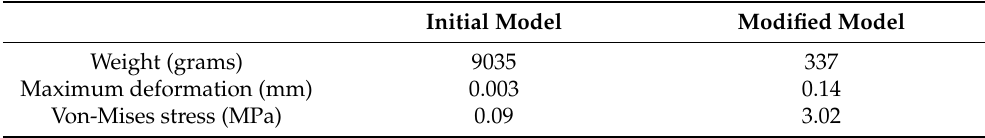
Table 4. Equivalent stress and maximum deformation for modified indigenous model. Table 5. Comparison of initial and final topology optimized